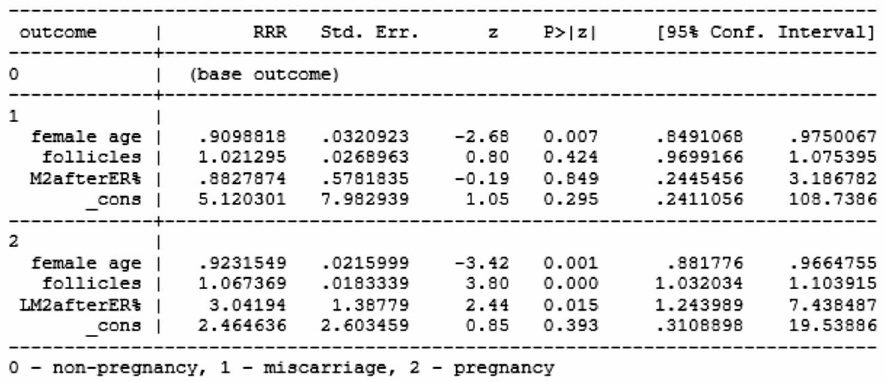
Table 2. The first multinomial logistic regression model built on the basis of information about retrieved oocytes and female age (Model I)